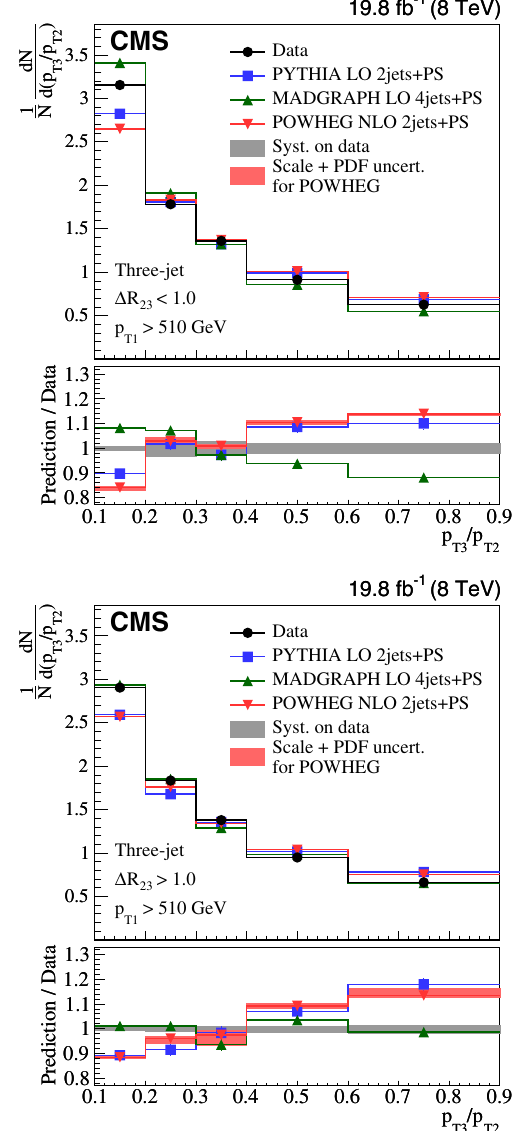
√ s = 8TeV compared to theory: (upper)